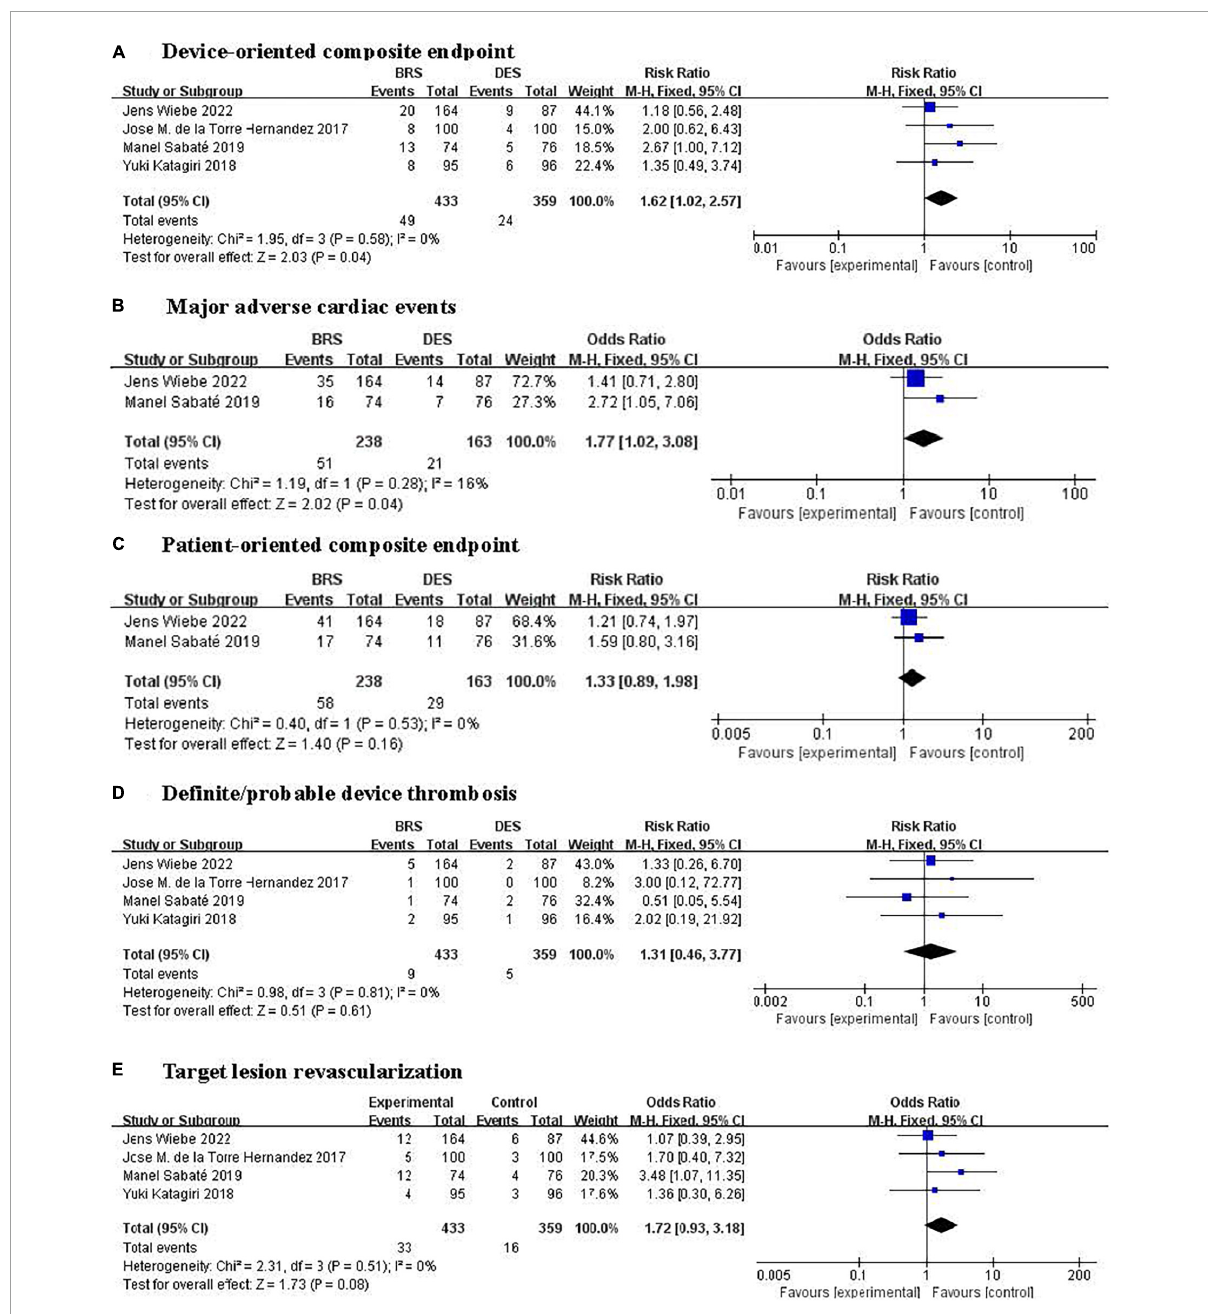
FIGURE2 Forest plots of effect of BRS and DES on clinical outcomes. (A) Device-oriented composite endpoint, (B) major adverse cardiac events, (C) patient-oriented composite endpoint, (D) definite/probable device thrombosis, and (E) target lesion revascularization. BRS, bioresorbable scaffolds; DES, drug-eluting